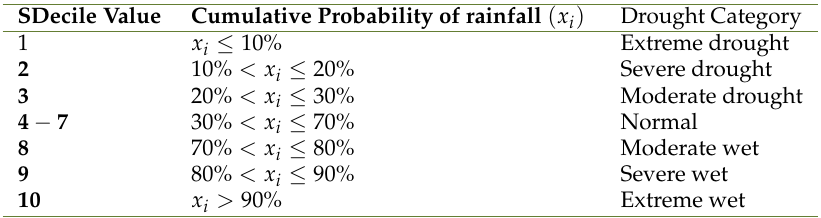
Table 3. Decile values and corresponding drought level. Source: Guttman [29].